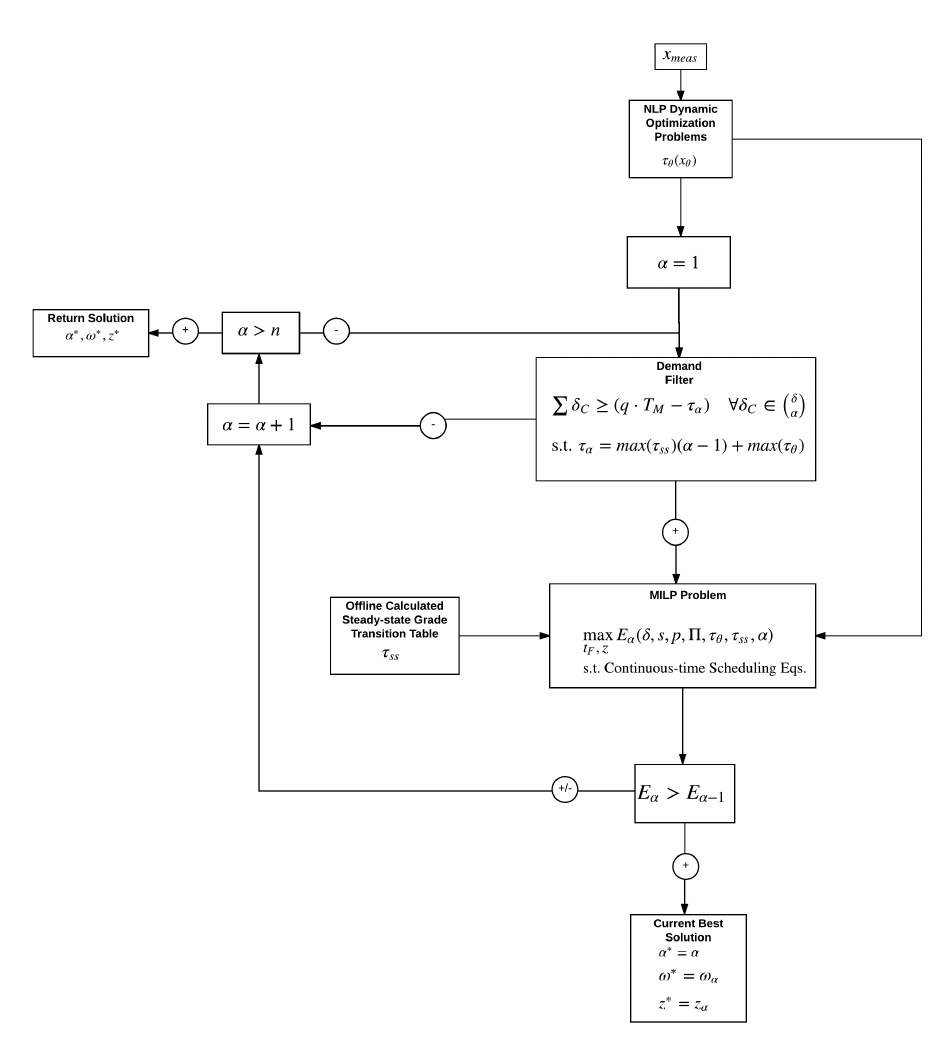
Figure 1. Diagram describing the integrated noncyclic scheduling and optimal control